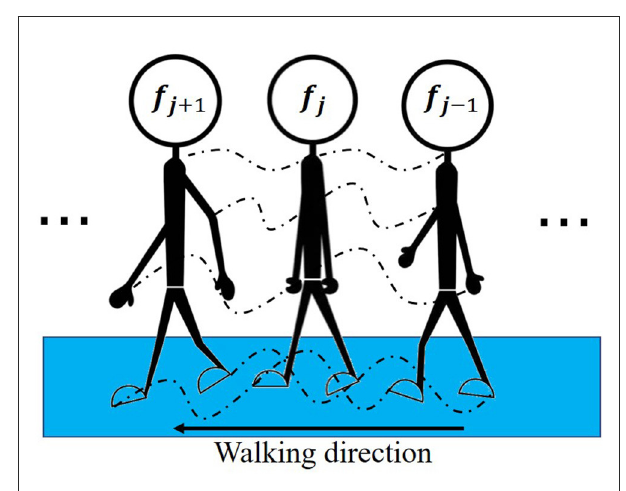
FIGURE3 Diagram of the interframe difference. f j − 1 , f j and f j + 1 represent three adjacent gait images in the gait video. The dotted line represents the movement trajectory of the key